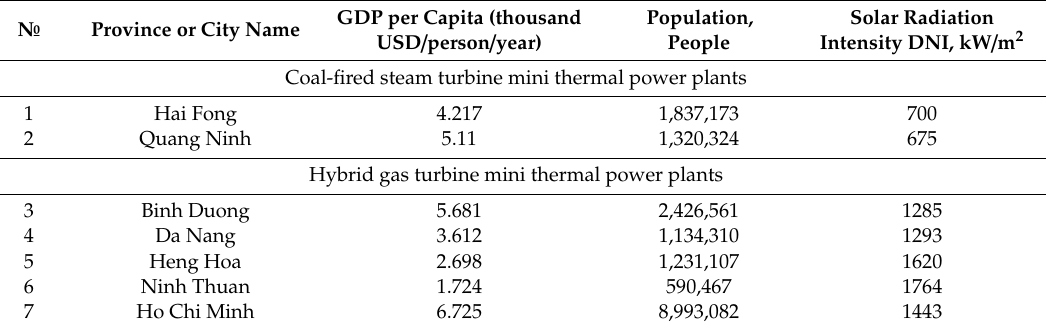
Table 1. The basic data on the provinces of the Republic of Vietnam selected for the placement of mini thermal power